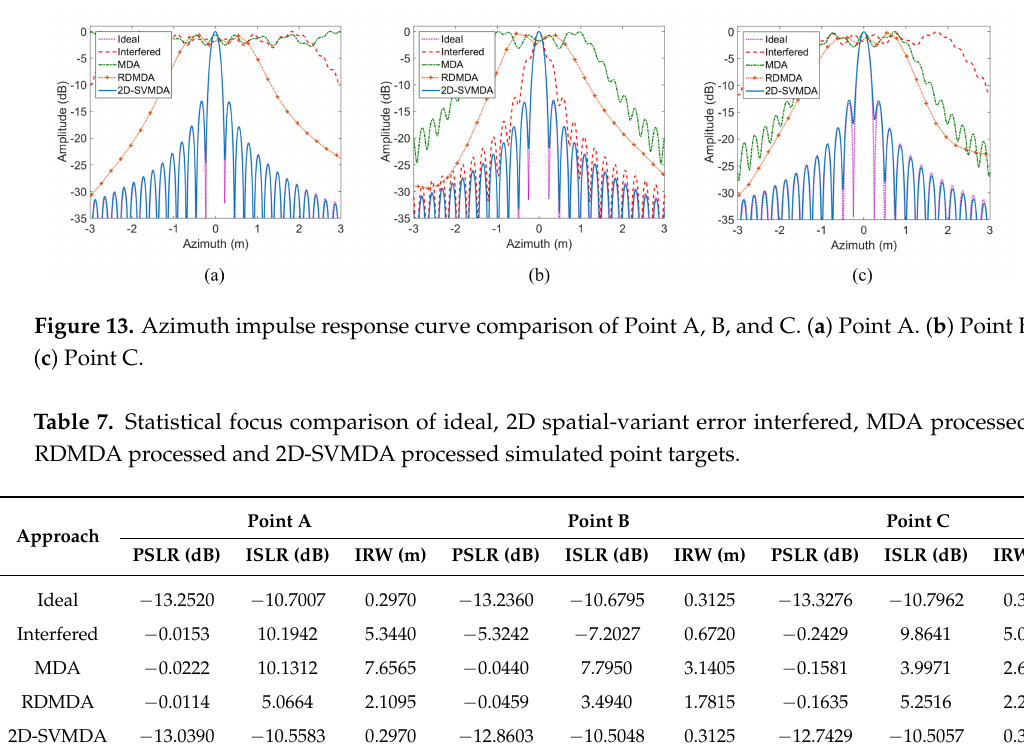
Figure 12. Ka-band point target simulation and magnified sub-scene. ( a ) Range- and azimuth-variant error interfered image. ( b ) Processed with conventional MDA. ( c ) Processed with RDMDA. ( d ) Processed with 2D-SVMDA.